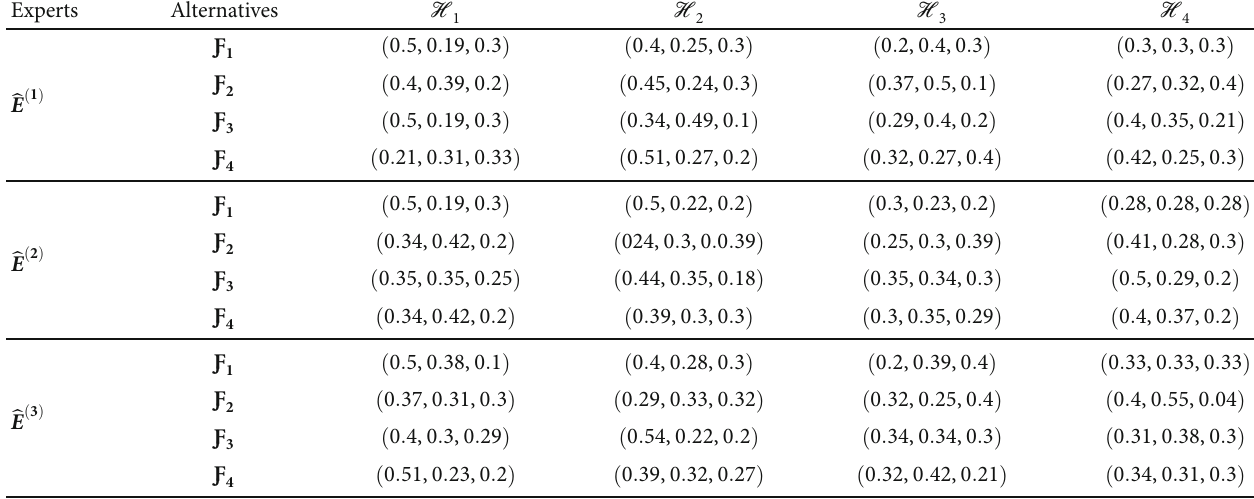
Table 2: The decision matrix from experts.